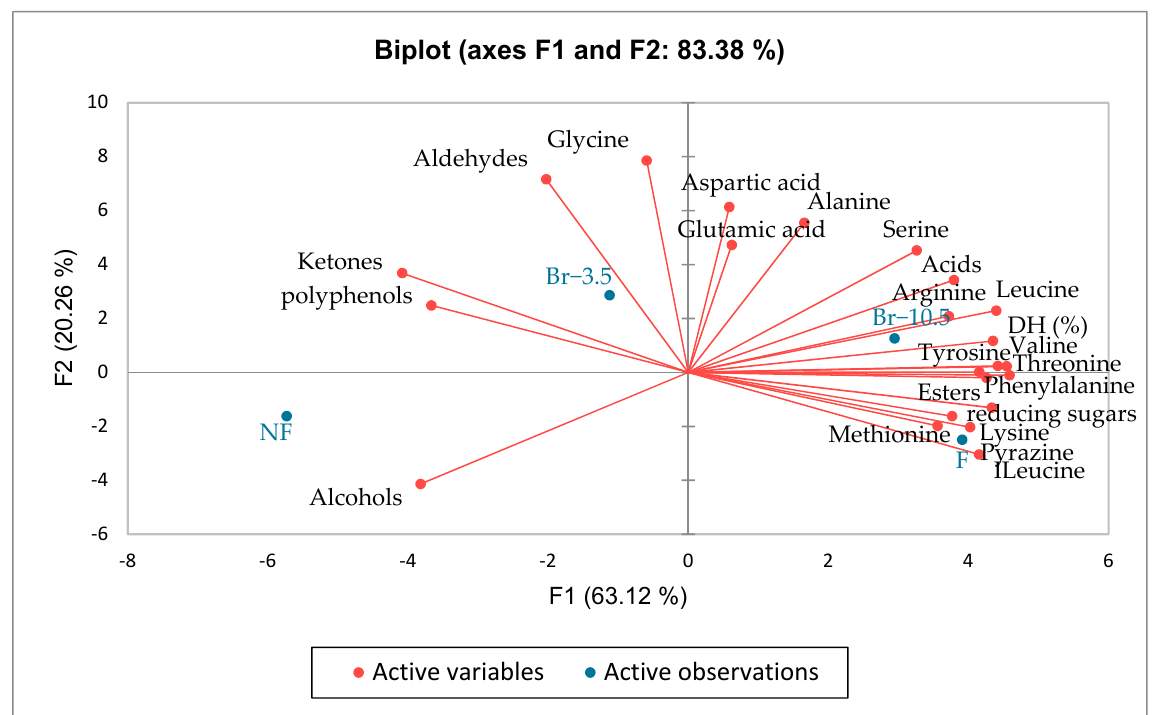
Figure 5. Principal component analysis (PCA) biplot for correlations between parameters of the degree of hydrolysis, free amino acids, reducing sugars, polyphenols, free amino acids, and volatile compounds with different treatments of unfermented cocoa beans: NF = unfermented cocoa beans; Br − 3.5 = bromelain concentrations of 3.5 U/mL for 8 h; Br − 10.5 = bromelain concentrations of 10.5 U/mL for 6 h; F = fermented cocoa beans.